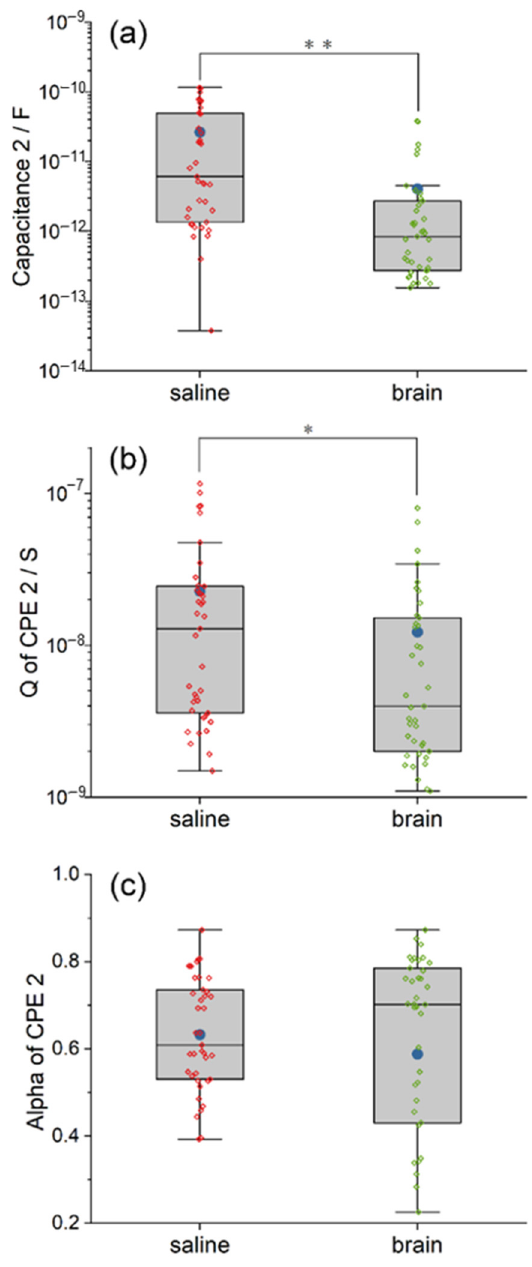
Figure 6. The comparison between the equivalent circuit model of saline and pig brain in the fitted value of C2 ( a ), Q ( b ) and alpha ( c ) of CPE2. The difference in C2 and CPE2 indicates that the Parylene C was in different states. Significance level was set at * p < 0.05; ** p < 0.01.